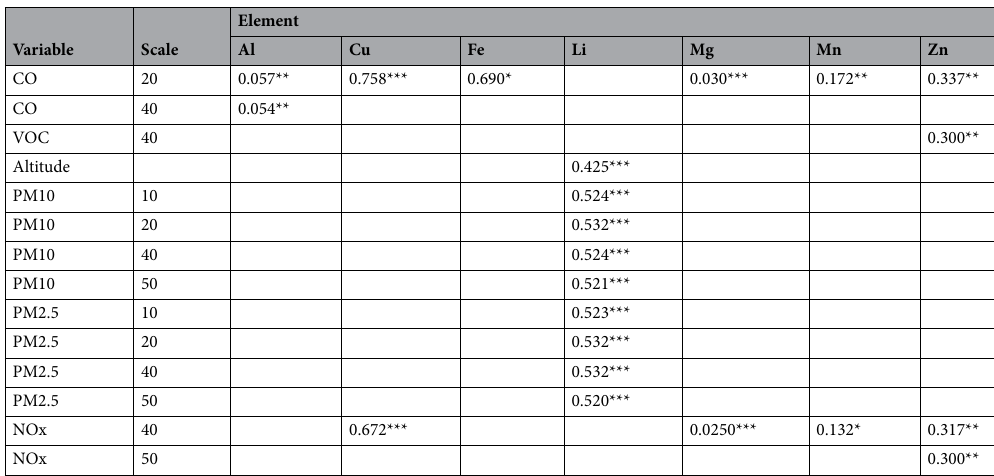
Table 3. Significant coefficients of the best-supported GLMM accounting for the concentration of trace elements in snow samples collected at the Andes. Predictors quantified at different spatial scales are: Altitude; Volatile organic compounds (VOC), Nitrogen oxide (NOx); 2.5 μm and 10 μm particulate matter (PM2.5 and PM10, respectively) and carbon monoxide (CO). Significance levels of coefficients are: *p < 0.05, **p < 0.01, ***p <